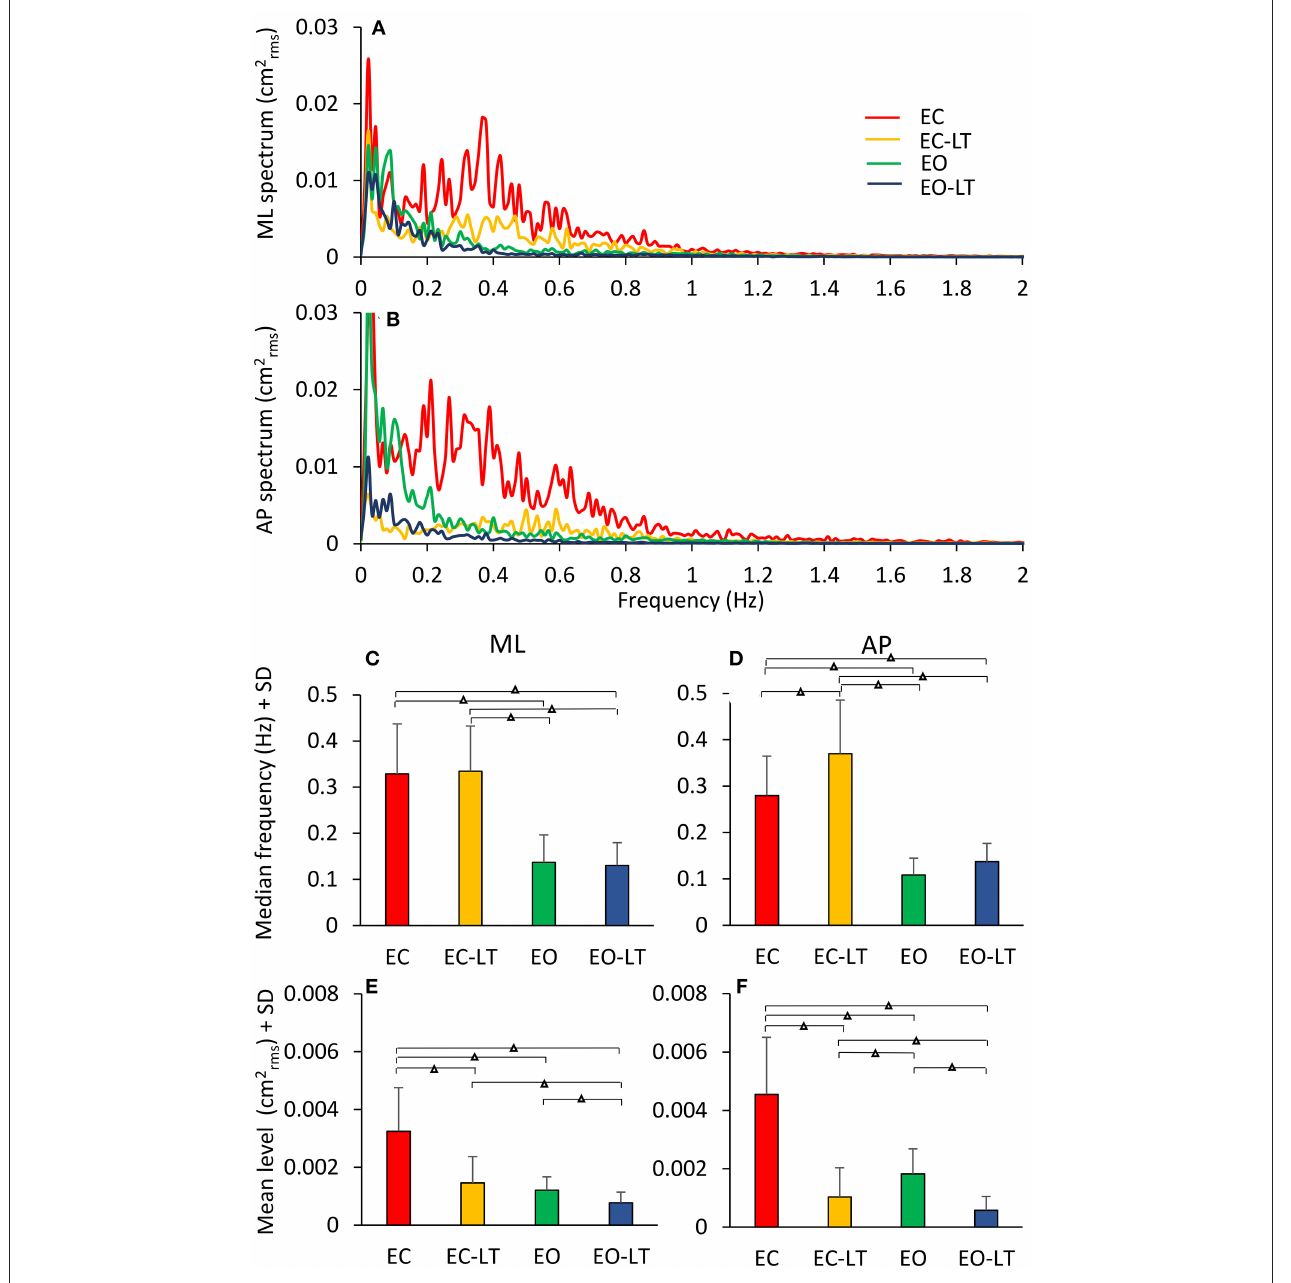
FIGURE 6 | Power spectra under different sensory conditions. This contrasts the spectra during the trials performed on foam without vision (EC, red), with vision (EO, green), and with the addition of touch (EC-LT, yellow; EO-LT, blue). Obviously, the level of the spectrum for all the “stabilised” conditions is smaller than with EC (A,B) . The median frequency of the spectrum (C,D) is definitely smaller with vision (EO and EO-LT) than without vision (EC and EC-LT), both in the frontal and sagittal plane. Conversely, the mean level (E,F) is small in the three “stabilised” conditions. In this case, the reduction in the mean level also applies to EC-LT. Triangles indicate significant differences ( 1 p <